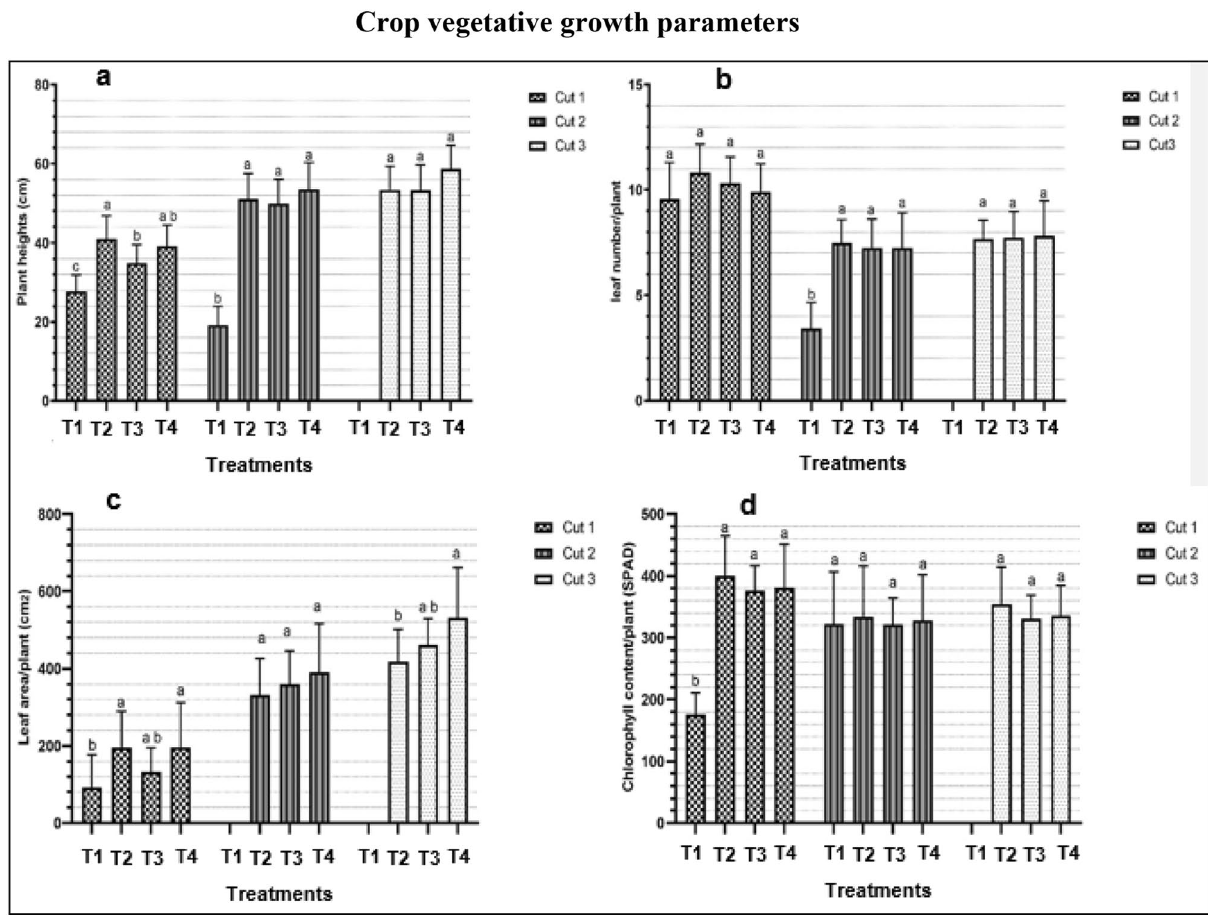
Figure 2. Effect of different treatments on vegetative growth; ( a ) Plant height; ( b ) Leaf number; ( c ) Leaf area, and ( d ) chlorophyll content at different cut numbers. Data are expressed as mean ± SD (n = 12). Error bars represent the standard deviation. Bar columns within the same cut number having the same letter at the top are not significantly different (P > 0.05). T1 Deep water culture, T2 October, T3 Beni suef, T4